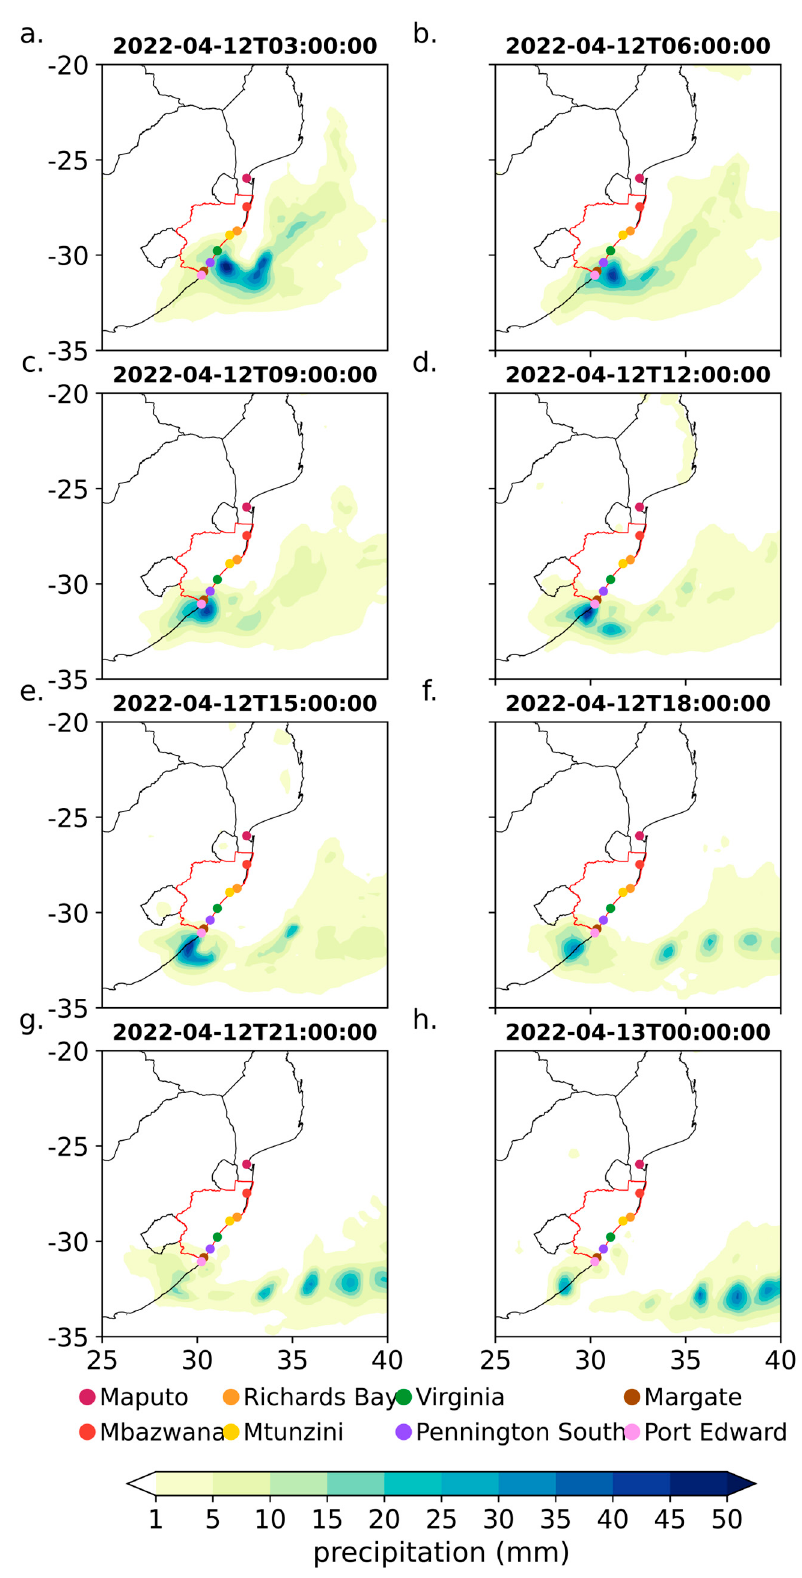
Figure A4. ERA5 precipitation (shaded; mm) accumulated at 3 hourly intervals, shown at ( a ) 0300 UTC, ( b ) 0600 UTC, ( c ) 0900 UTC, ( d ) 1200 UTC, ( e ) 1500 UTC, ( f ) 1800 UTC, ( g ) 2100 UTC on 12 April 2022 and ending at ( h ) 0000 UTC 13 April 2022. The locations of the stations discussed in the text are depicted by the coloured circles.